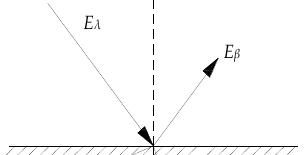
Pink coating temperature Polynomial fitting curve of white coating temperatures Polynomial fitting curve of pink coating temperatures